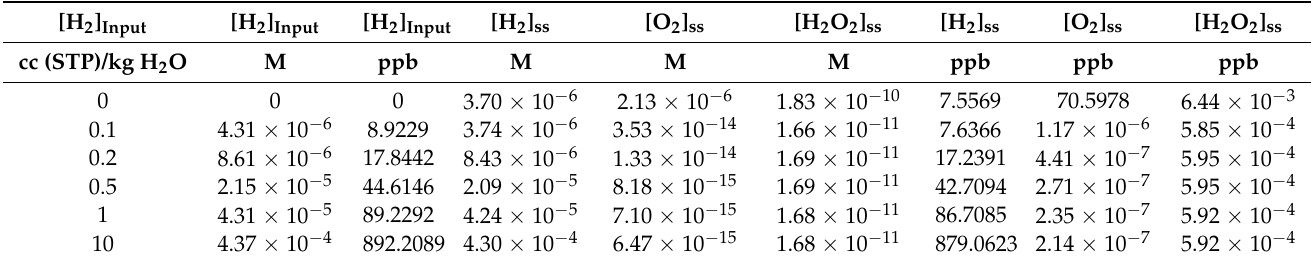
Table 24. Steady-state concentrations of H 2 , O 2 , and H 2 O 2 as a function of the concentration of hydrogen added to the coolant for the simulated environment at the PFA inlet of the IBED PHTS after 50 s transit through the OPFA from the PFA outlet of the previous cycle. These concentrations can be also considered as the concentrations within the